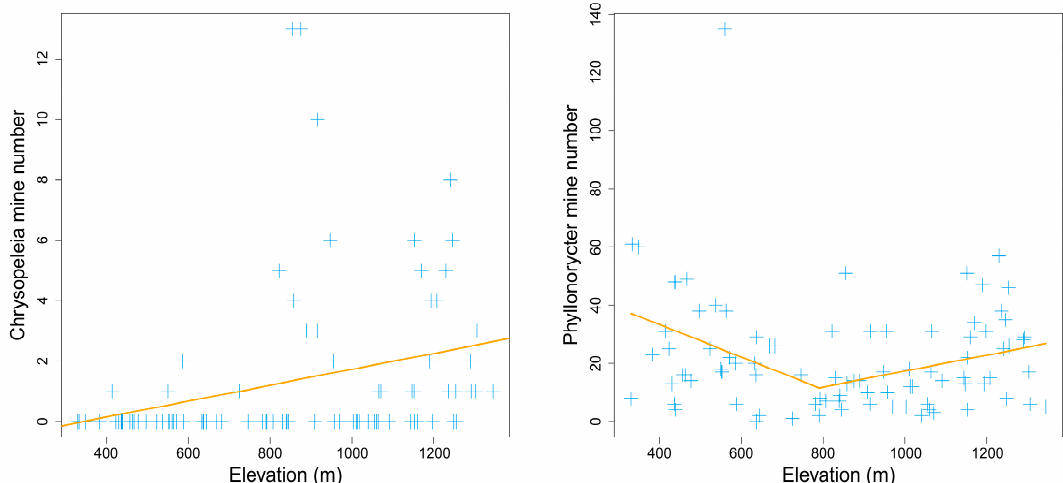
Figure 3. Elevation increasing and V-shaped pattern of mine numbers on Quercus variabilis Blume. The orange line was fitted with the piecewise linear model.